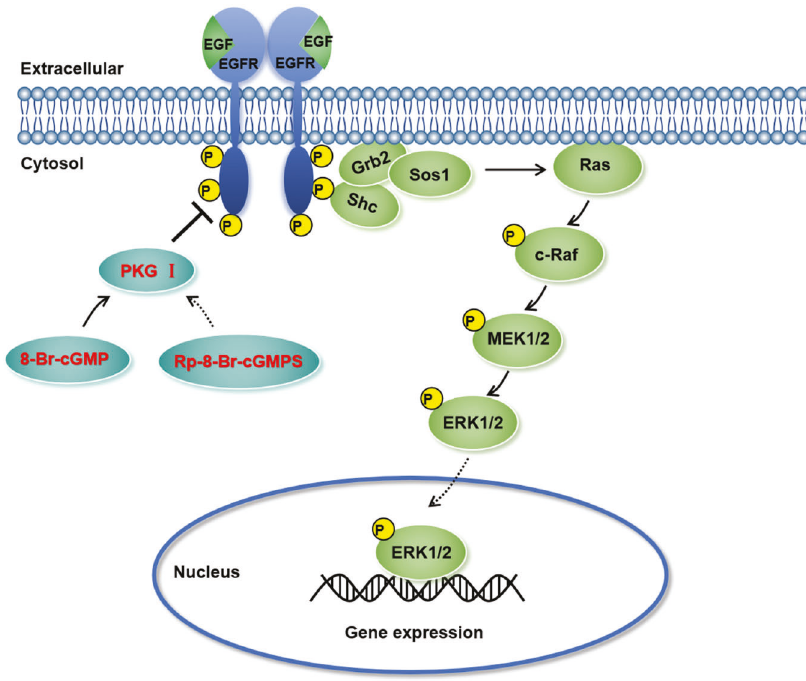
Fig. 7 Schematic model of the activated PKG I attenuates EGF-induced EGFR/MAPK/ERK signaling in ovarian cancer. By binding to EGFR, the activated PKG I inhibit the expression of the EGFR/MAPK/ERK pathway and thereby decreases the expression of nuclear phosphorylated ERK1/2, ultimately leading to suppressed cell growth and metastasis in human